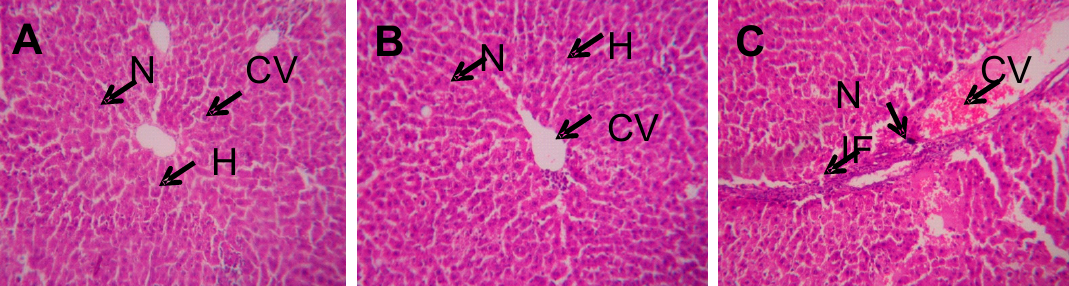
Figure 1. Histopathological analysis of experimental liver tissues. A —Control, B —Non toxic dose, C —Toxic dose induced liver tissue. N—Nucleus, H—Hepatocyte, CV—Central vein, IF—Inflammatory cells.